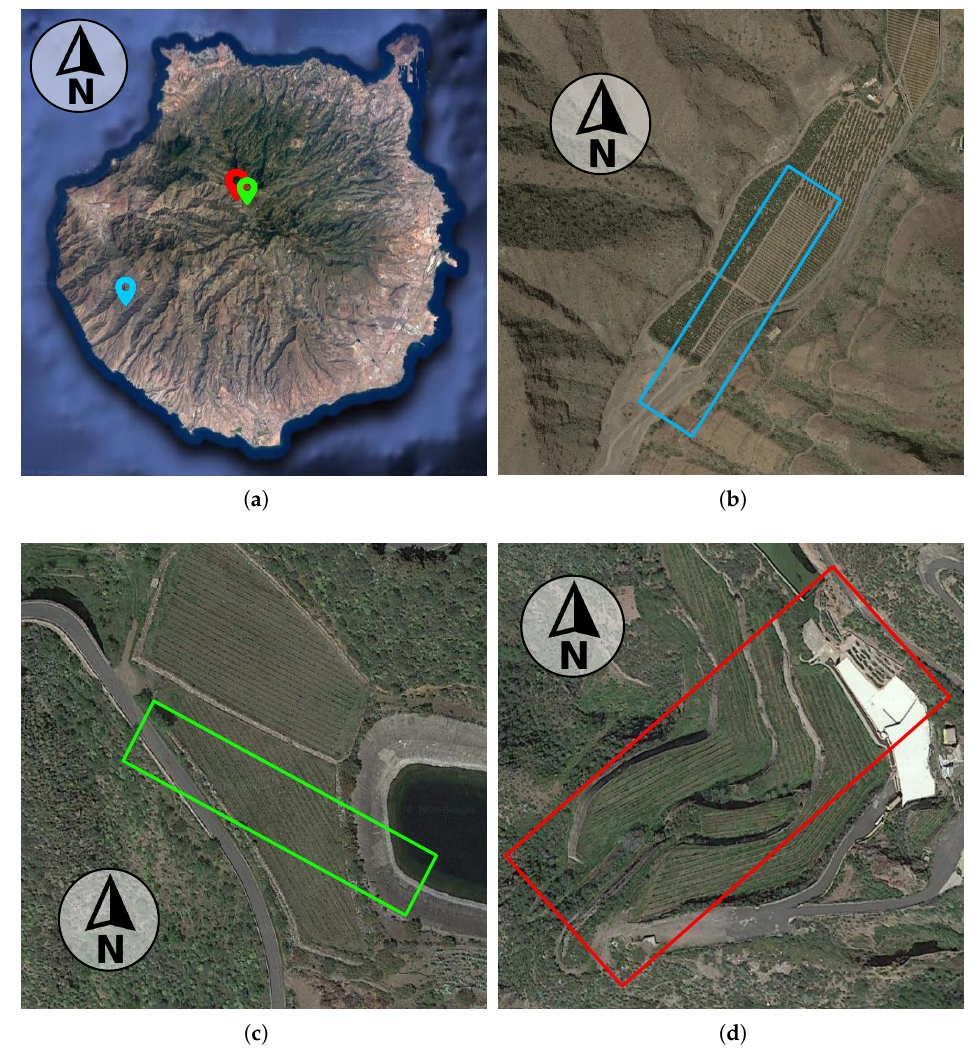
Figure 3. Google Maps pictures of the farming areas corresponding to the hyperspectral images that are used in this work. ( a ) Location of the terrains on the island of Gran Canaria. ( b ) Area covered during the first flight campaign over a banana plantation. ( c , d ) Area covered during the second and third flight campaigns over different